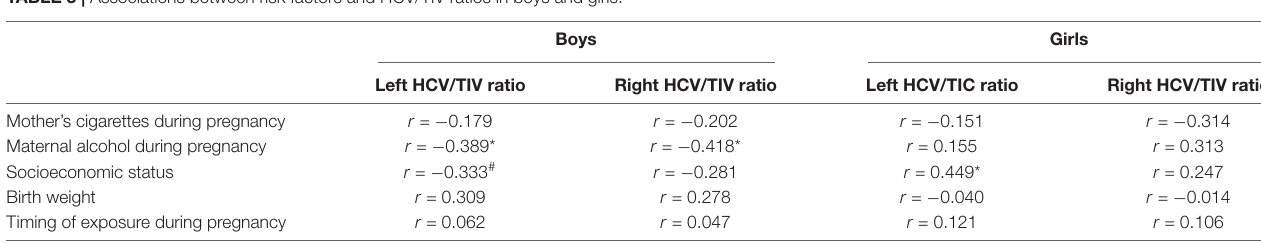
TABLE 3 | Associations between risk factors and HCV/TIV ratios in boys and